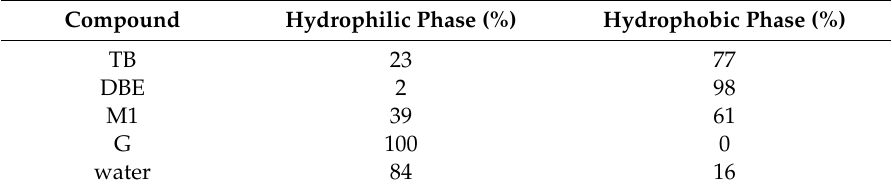
Table 1. Distribution of the compounds involved in the etherification of G in the hydrophilic and hydrophobic